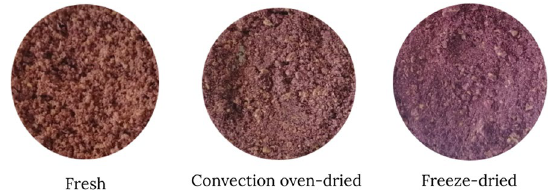
1 Values are expressed as mean standard deviation ( n 3). Means with + = different superscripts (a-c) within a row, indicate significant differences ( p <0.05) using Tukey’s HSD test 2 Values are expressed as percent fresh basis (%fb) Fig. 1 Ground and sieved bignay pomace